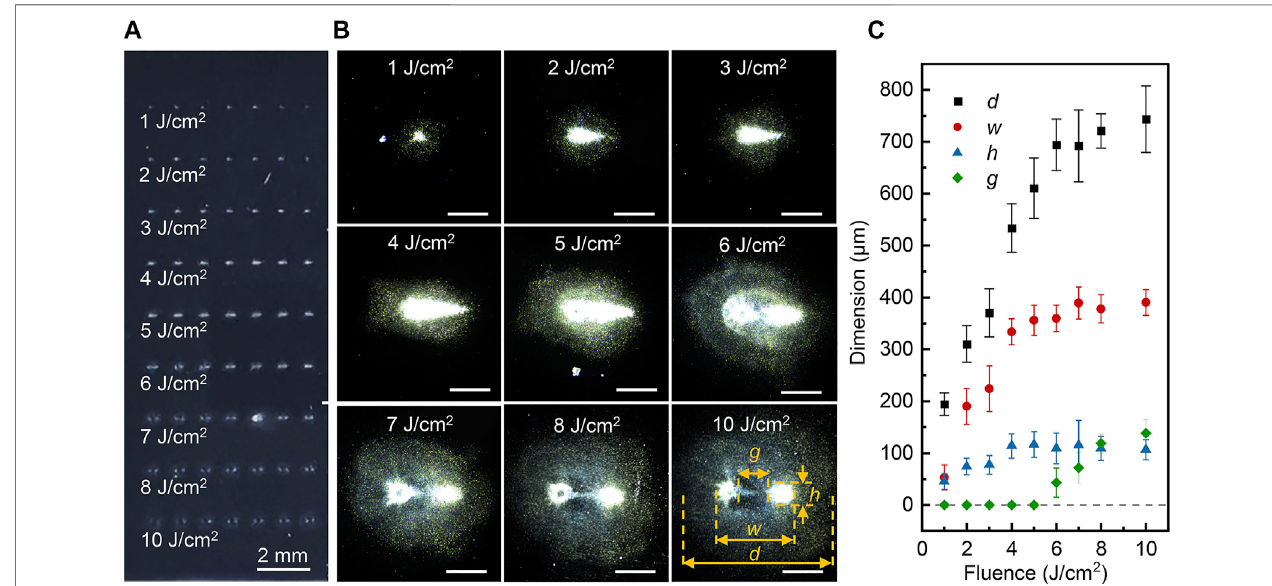
FIGURE 2 | (A) Image of the laser-transferred dot array. (B) Dark- fi eld microscope images of the transferred dots at a laser fl uence from 1 to 10 J/cm 2 . The scale bars indicate 200 μ m. (C) Geometric dimensions as a function of laser fl uence.